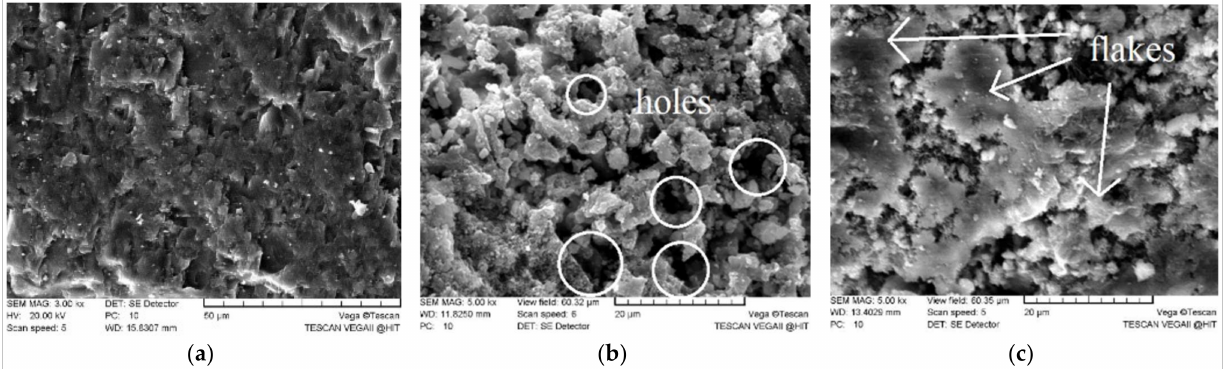
Figure 8. SEM images of the plain concrete in different corrosion humidity: ( a ) no corrosion, ( b ) humidity 71% (time 21 days), and ( c ) humidity 85% (time 35 days).